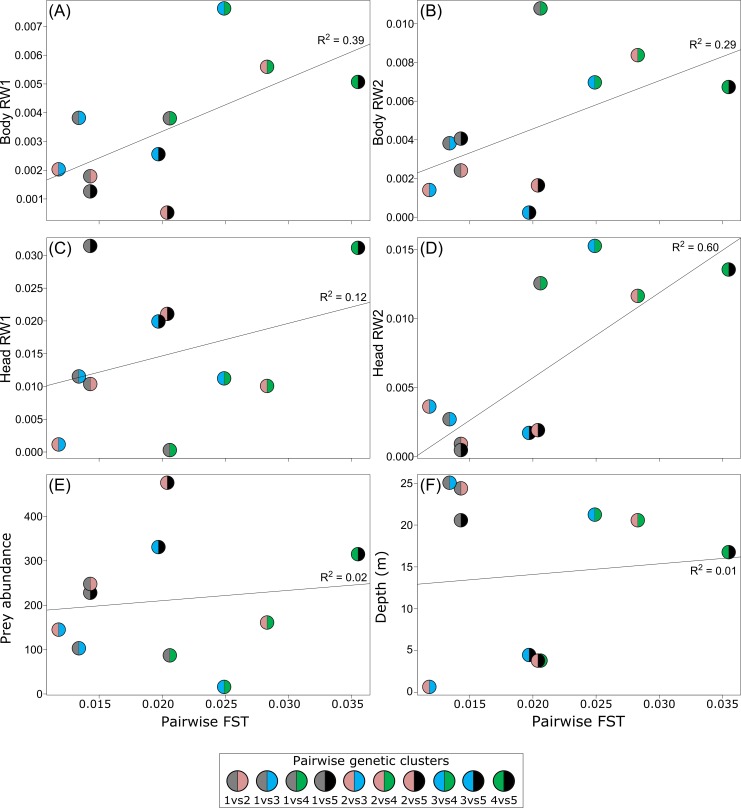
Visualization of Mantel tests: genetic distance vs. morphological and ecological variables.Shown are comparisons of genetic distance (pairwise FST) vs. (i) the absolute difference in mean relative warp (RW) score for the first two RWs for body (A, B) and head morphology (C, D); (ii) absolute difference in prey abundance (E); and (iii) the absolute difference in median depth (m) (F). Body RW1 and 2 represent 26% and 17% of the total variation; whereas head RW1 and 2 represent 36% and 23% of the total variation. The remaining visualizations of Mantel tests can be seen in Fig S8.4 in S8 File.